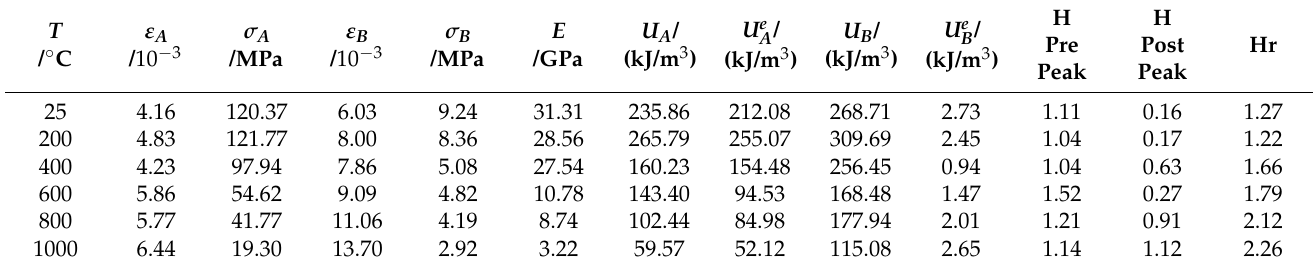
Table 2. Mechanical parameters and energy drop coefficient of rock at different temperatures.